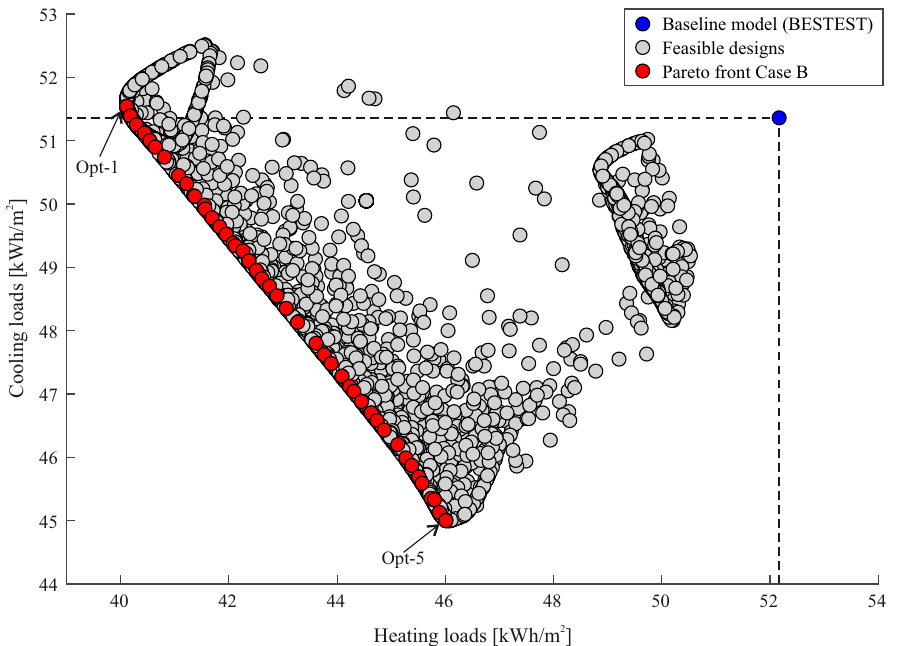
Figure 7. Optimization results of the annual ideal loads for heating and cooling obtained for Case B. Opt-1 is the best design for heating, and the same is obtained in Case A. This is because the design space was only enlarged with higher thermal conductivity values than the original PCM-based panel. This aspect is more deeply analyzed in Section 3.3. Opt-5 achieves load reductions of 11.81% and 12.38% for heating and cooling, respectively. Unlike the best design for cooling in Case A (Opt-3), Opt-5 achieves a large load reduction for cooling but also obtains a similar improvement for heating. Table 7. Performances of the optimized designs for Case B. The best design for each case is in bold. Heating